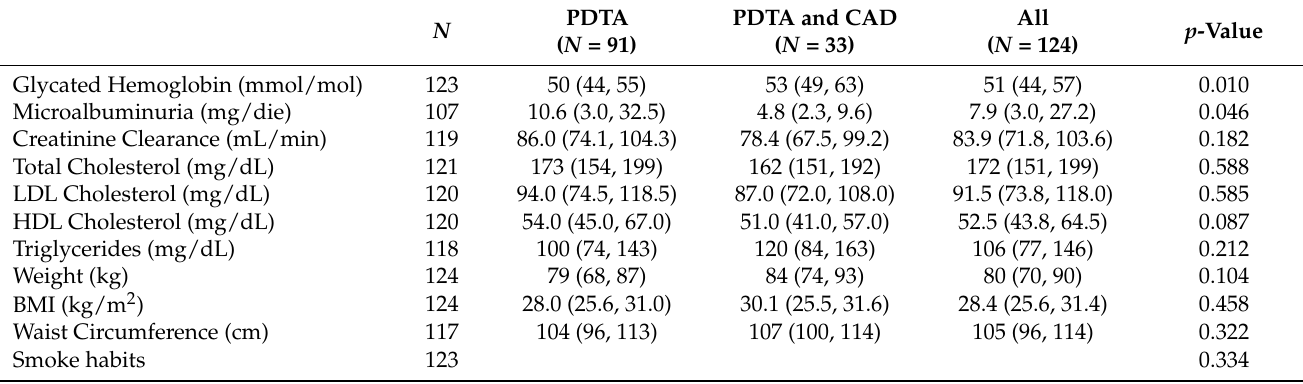
Table 3. Descriptive table on biochemical data and clinical information collected during follow-up PDTA examination. Data are expressed as median (I, III quartile) for continuous variables and absolute numbers (percentage) for categorical